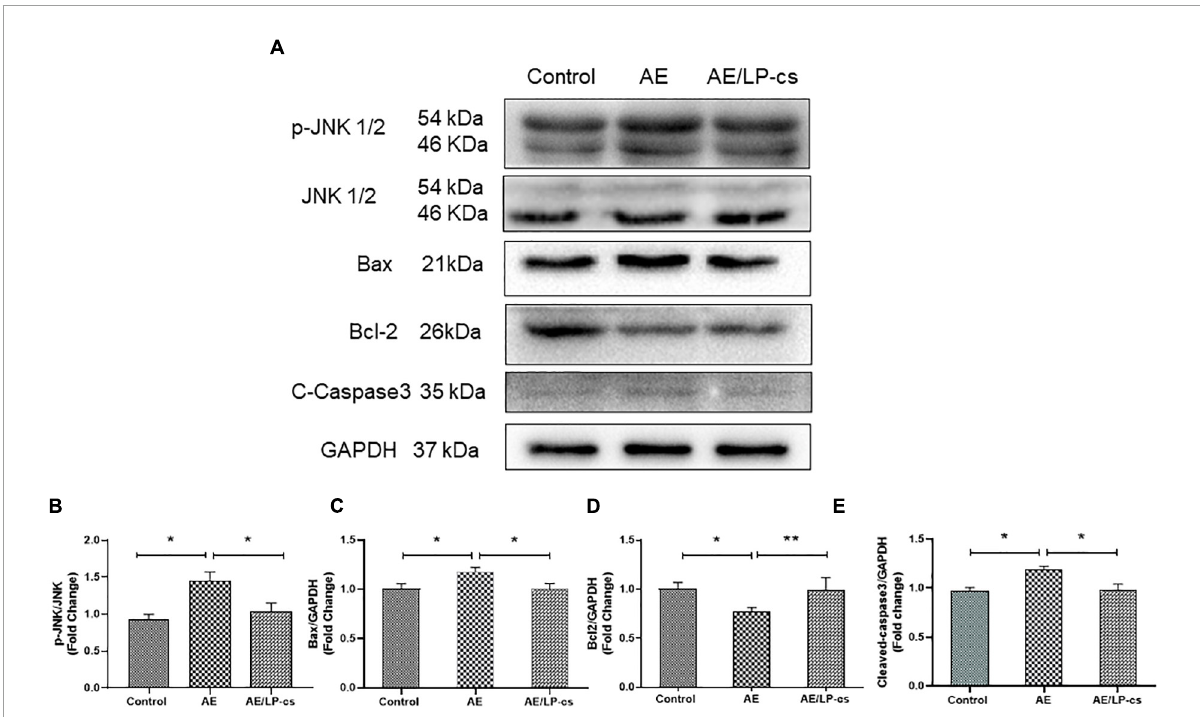
FIGURE3 Lactobacillus plantarum culture supernatants alleviates alcohol-induced hippocampal apoptosis. (A–E) Western blot and quantitative analysis of JNK, p-JNK, Bax, Bcl2, and Cleaved-Caspase3 expressions in the hippocampus from the mice. Control vs. AE and AE vs. AE/LP-cs, * p < 0.05, ** p < 0.01, n =